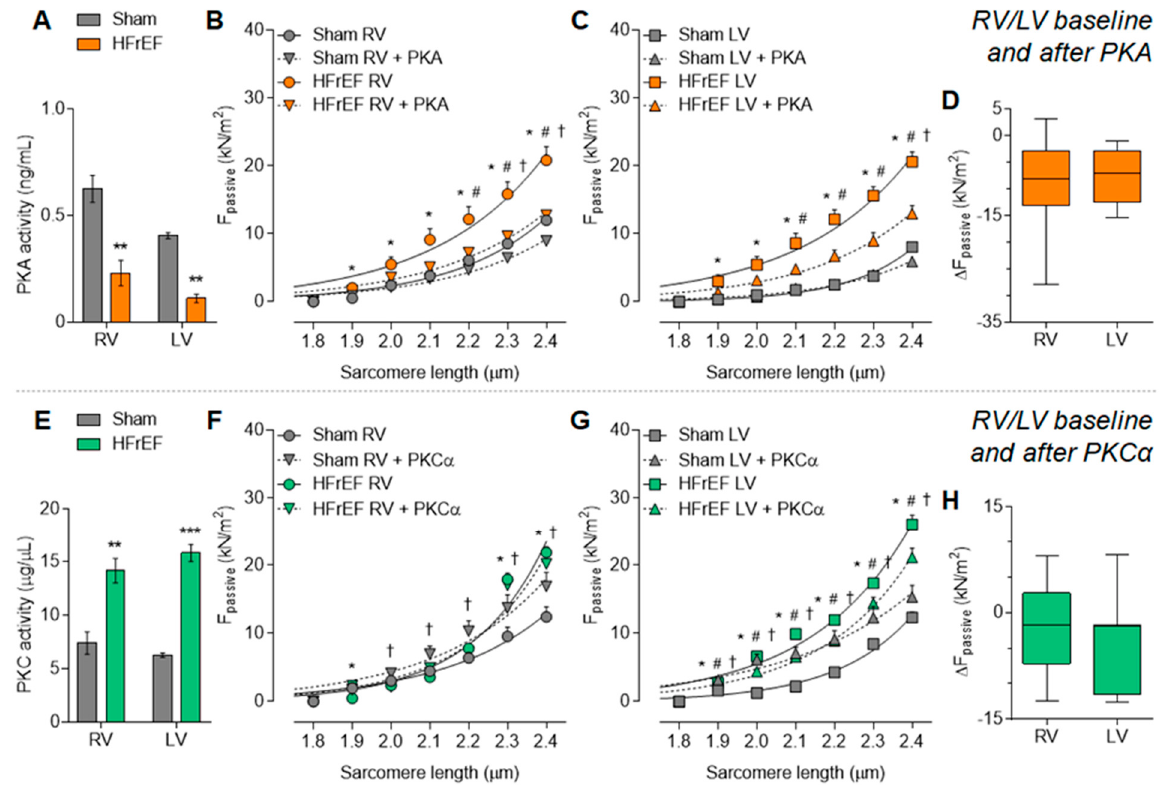
Figure 3. Uniform changes of protein kinase-mediated cardiomyocyte passive stiffness (F passive ) in the post-ischemic rat heart: Protein kinase A (PKA) and C (PKC). PKA activity is shown in HFrEF and Sham groups ( A ). F passive is presented before (baseline) and after PKA in vitro administration in the RV ( B ) and the LV ( C ) of HFrEF and Sham hearts, with the corresponding PKA in vitro effect (after vs. before) on F passive of HFrEF samples ( D ). PKC activity is shown in HFrEF and Sham groups ( E ). F passive is presented before (baseline) and after PKC α in vitro administration in the RV ( F ) and the LV ( G ) of HFrEF and Sham hearts, with the corresponding PKC α in vitro effect (after vs. before) on F passive of HFrEF samples ( H ). Data are shown as mean ± SEM; panels A and E: n = 3 mean of 3 samples/group; panels B–D and F–H: n = 8–14 cardiomyocyte/3–5 heart/group. Panels A and E: ** p < 0.01, *** p < 0.001 HFrEF vs. Sham (same ventricle). Panels B–C and F–G: * p < 0.05 HFrEF vs. Sham; # p < 0.05 HFrEF after PKA/PKC α vs. HFrEF baseline; † p < 0.05 Sham after PKA/PKC α vs. Sham.